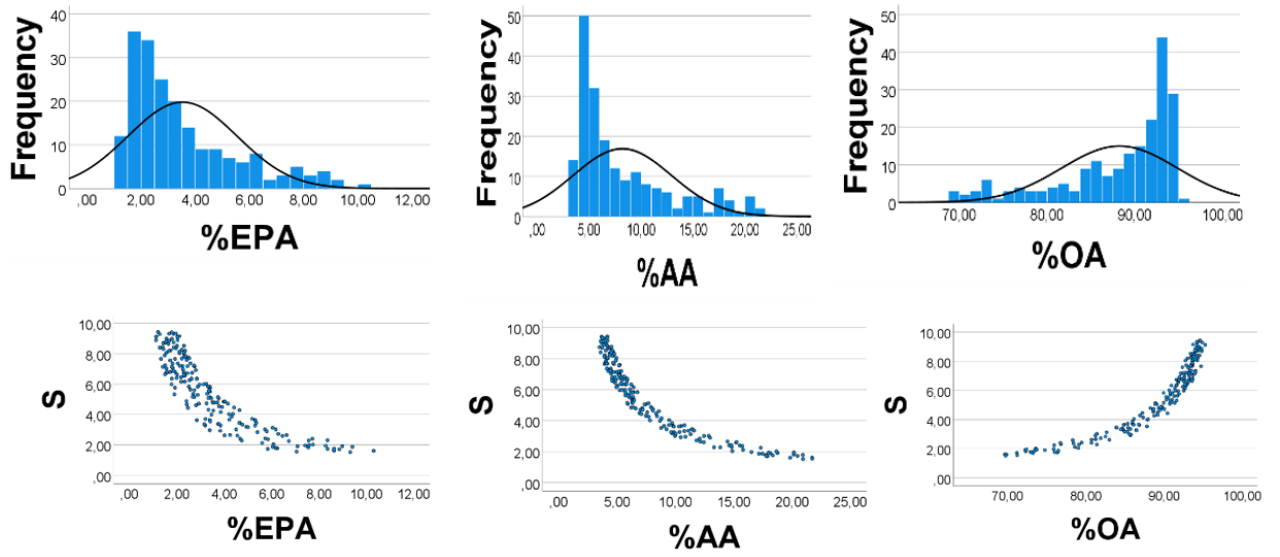
Figure 2. Computer experiment to elucidate associations between relative amounts of OA ’ , EPA ’ , and AA ’ , see text. S = OA ’ + EPA ’ + AA ’ . RANDOM numbers ( n = 200) were used instead of true values; however, ranges were like those found in chicken muscle, i.e., 0.1–0.2 for EPA ’ , 0.3–0.4 for AA ’ , and 1–9 for OA ’ . Upper panels: Frequency distributions of %EPA ’ , %AA ’ , and %OA ’ . Cutoff values of %EPA ’ , %AA ’ , and %OA ’ quartiles were 2.1, 2.9, 4.4; 3.6, 4.9, 7.4; 88.5, 92.3, 94.4%, respectively. Skewness of the %EPA ’ , %AA ’ , and %OA ’ histograms were 1.42, 1.43, and −1.34, respectively (SE = 0.17 for all). Lower panels: Scatterplot of S vs. % EPA ’ (% AA ’ , %OA ’ ). Spearman ’ s rho = −0.915 for S vs. %EPA ’ ; −0.956 for S vs. %AA ’ ; and 0.967 for S vs. %OA ’ , p < 0.001 for all. Note: In the figure we have omitted the random number mark ( ‘ ) on the variables.